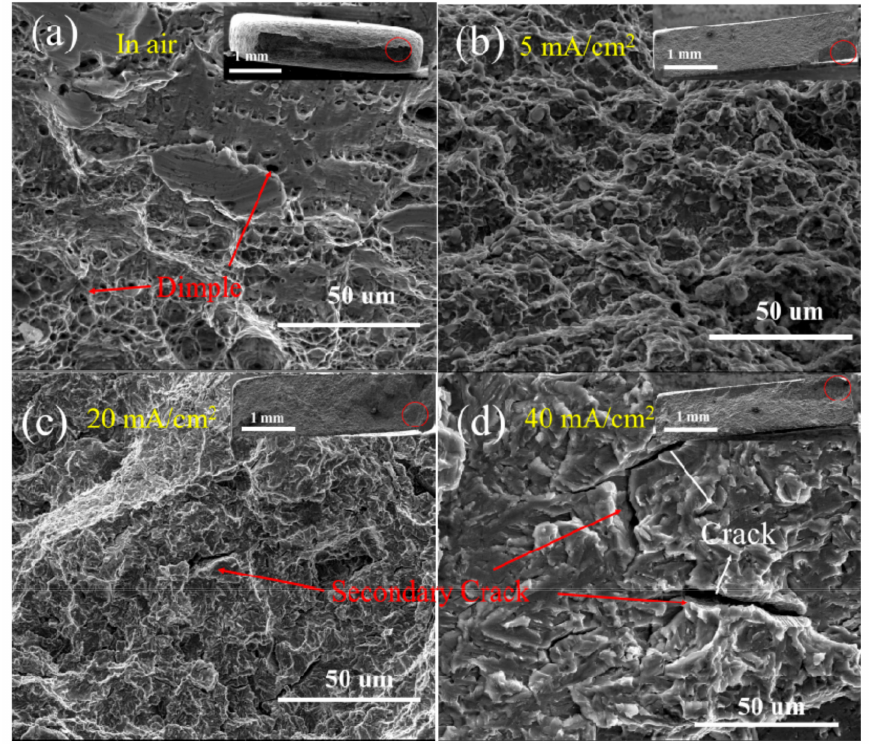
Figure 7. The fracture surface of the HAZ samples tested in ( a ) air and during in situ hydrogen charging at di ff erent current densities of ( b ) 5, ( c ) 20, and ( d ) 40 mA / cm 2